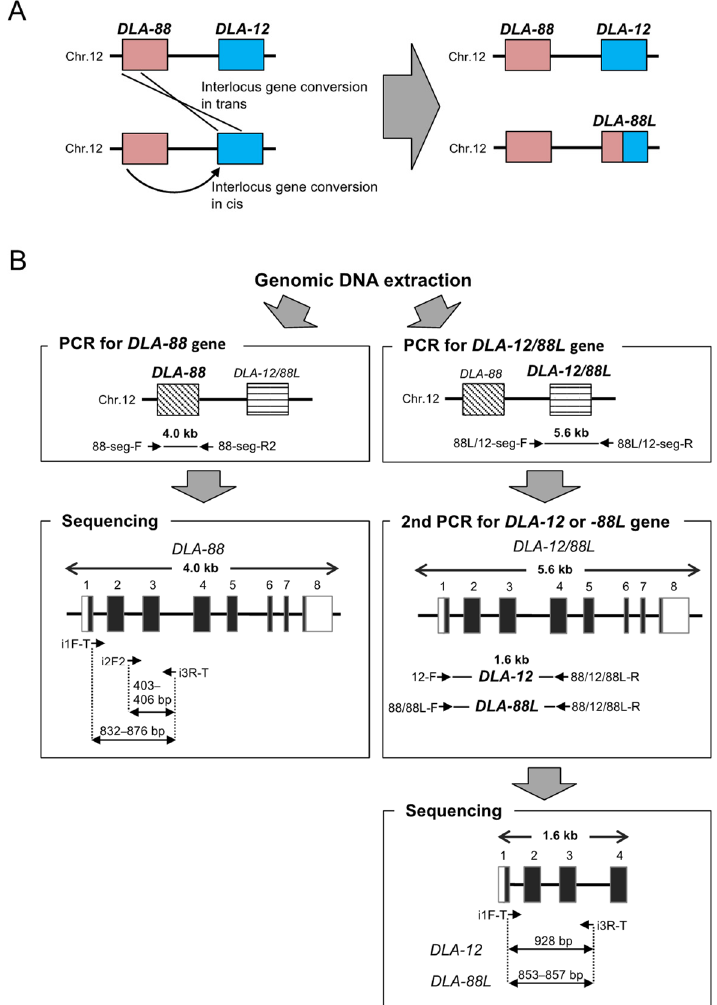
Figure 1. Schematic representations of haplotype structures and typing method for DLA-I genes. ( A ) Two different haplotype structures associated with DLA-12 and DLA-88L locus. Interlocus gene conversion events in cis or trans between DLA-88 and DLA-12 are likely to be responsible for generating the DLA-88L locus. ( B ) Flow chart for locus-specific DLA typing method for DLA-88 , DLA-12 , and DLA-88L genes with genomic DNA. White and black-filled boxes in the chart represent the schematic location of UTR and CDS regions of a DLA gene. Arrowheads indicate the location and direction of the primers with the primer names whose detailed information is described in Supplementary Table S1.